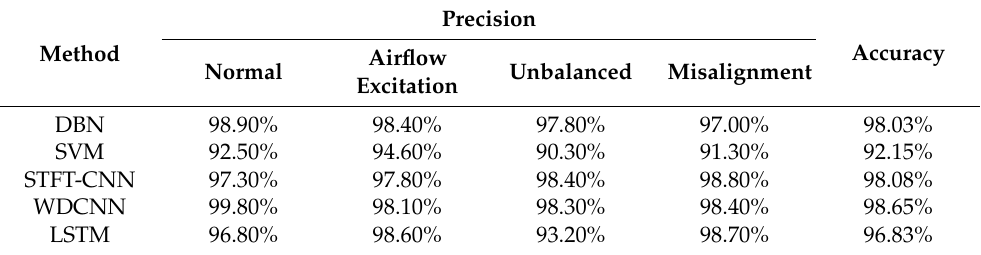
Table 5. Comparison of different diagnostic models.